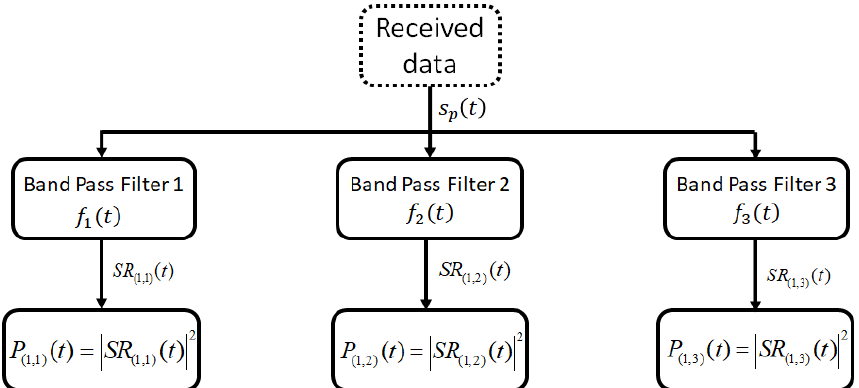
Figure 4. Steps of the proposed localization algorithm in the receivers